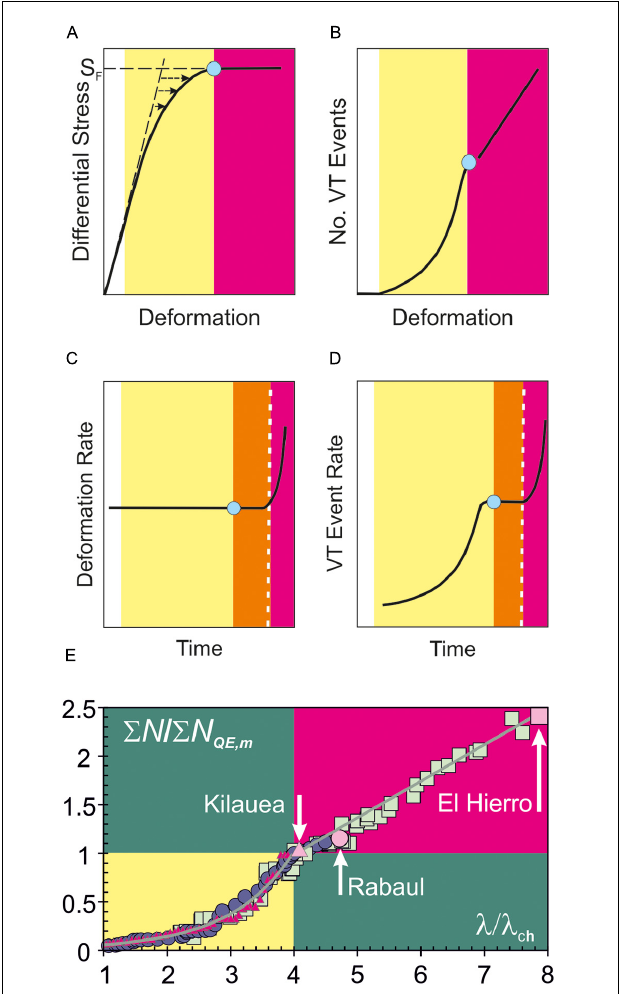
FIGURE 4 | (A) The amount of deformation due to fault movement is given by the difference between the equilibrium ( unbroken curve ) and ideal elastic ( broken line ) deformation trends. As the differential stress increases to its failure value S F , behavior evolves from elastic ( white ), through quasi elastic ( yellow ) to inelastic ( magenta ). This yields (B) accelerating quasi-elastic and linear inelastic increases in VT event with deformation. (C) For a constant rate of supplied stress, the deformation rate remains constant until a hyperbolic increase during inelastic behavior. The hyperbolic increase may be preceded by an interval of steady inelastic VT rate ( orange ). (D) The contemporaneous VT event rate increases from exponentially to hyperbolically with time, again possibly separated by an interval at constant rate (see Figure 2 ). (E) The model VT-deformation trends are consistent with normalized pre-eruptive sequences observed at El Hierro, Canary Islands, 18 July–12 October 2011 [ squares ; data from Istituto Geográfica Nacional [IGN] (2011) and Sagiya (2011)], Rabaul, Papua New Guinea, 1971–1994 [ circles ; data from Robertson and Kilburn (2016)], and Mauna Ulu on Kilauea, Hawaii, 14 November 1971–04 February 1972 [ triangles ; data from Bell and Kilburn (2011)]. See also Figure 3 . Measures of ground movement ( λ ; displacement and tilt) and their characteristic values ( λ ch ) are used as proxies for deformation. In all three cases, inelastic behavior ( magenta ) began when λ / λ ch ≈ 4 and eruptions occurred ( violet symbols ) when λ / λ ch ≥ 4. The trends were normalized using the total number of VT events at the end of the quasi-elastic regime, (cid:54) N QE , m , and the characteristic ground movement λ ch . See Figure 5 for the non-normalized trends. Typical magnitude ranges for VT events were 0.5–2.0 for Rabaul, 1.0–2.5 for El Hierro and 1.5–4.0 for Mauna